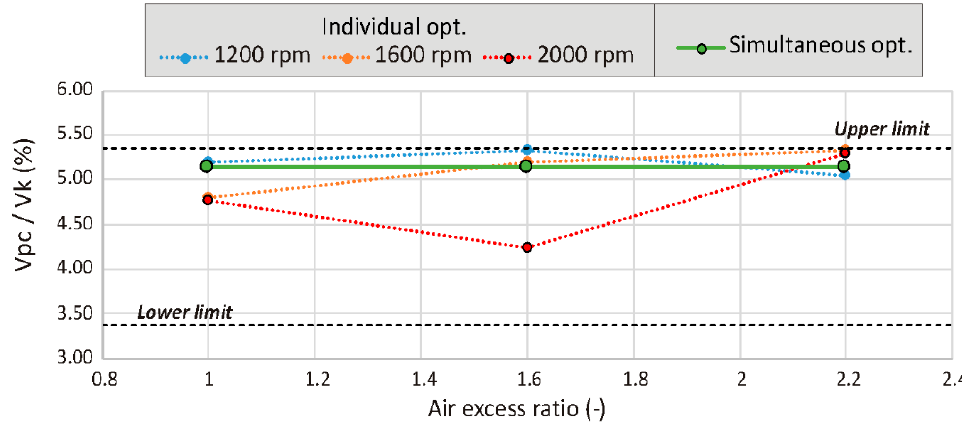
Figure 12. Optimized pre-chamber volume ratio for individual and simultaneous optimization.